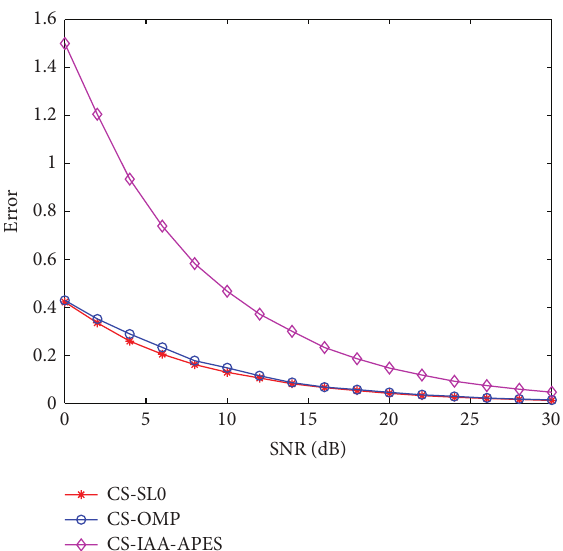
Figure 3: The signal recovery errors of three different methods with one incident signal.